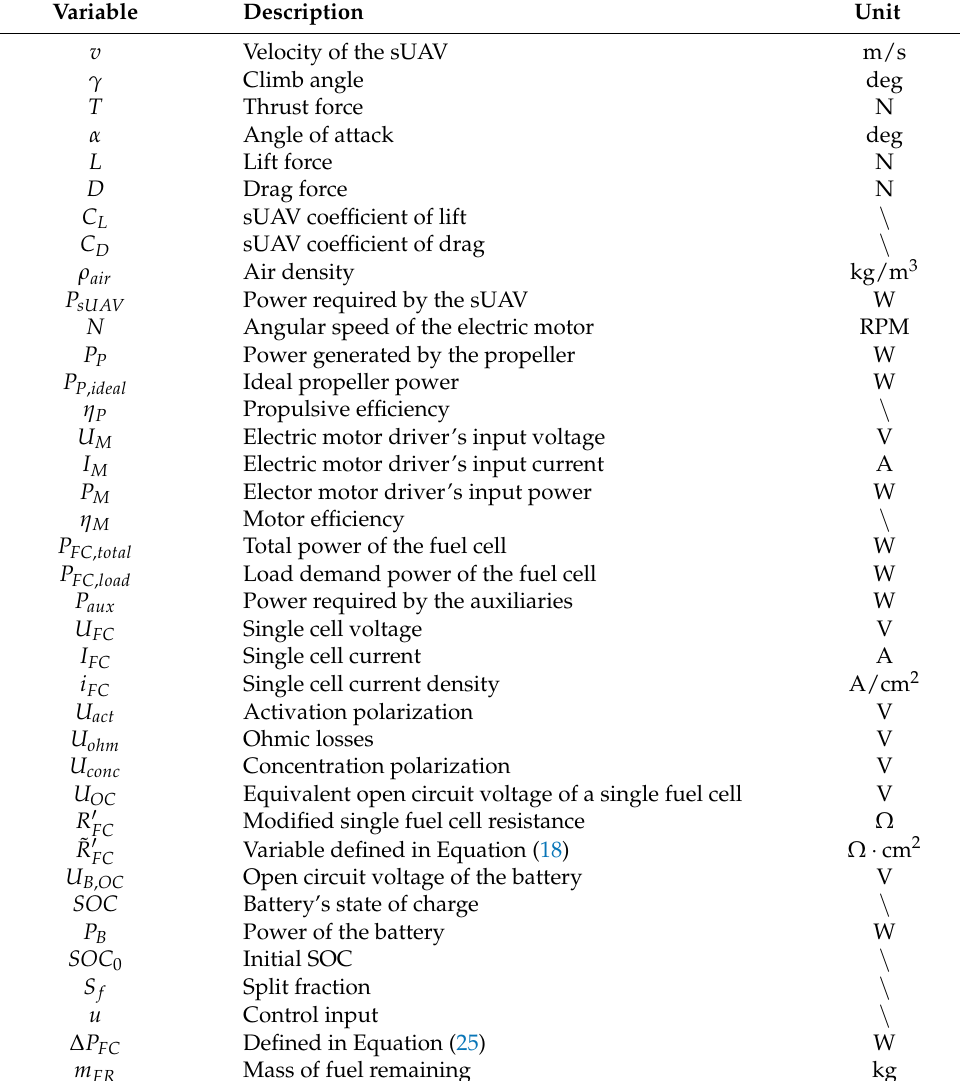
Table 1. List of variables used in the sUAV model. Variable Description Unit v Velocity of the sUAV m/s γ Climb angle deg Thrust force Angle of attack